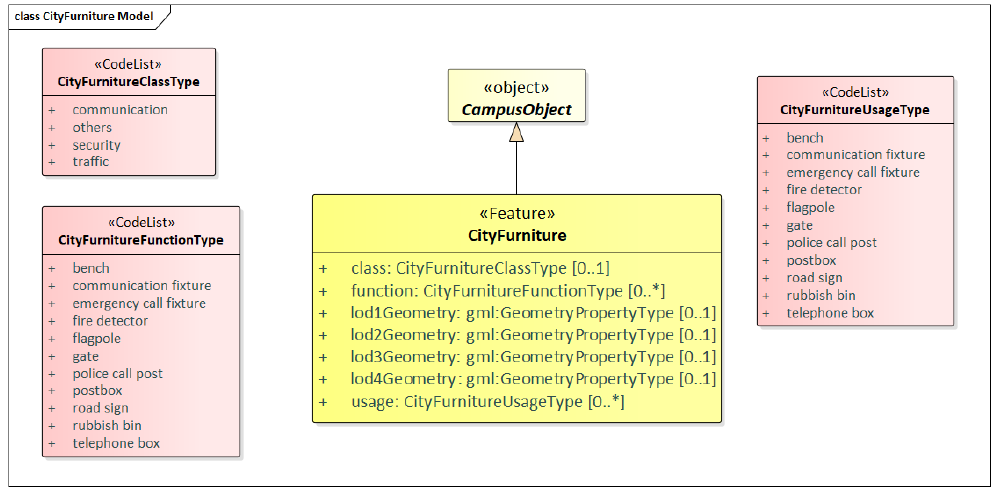
Figure 11. UML diagram of city furniture